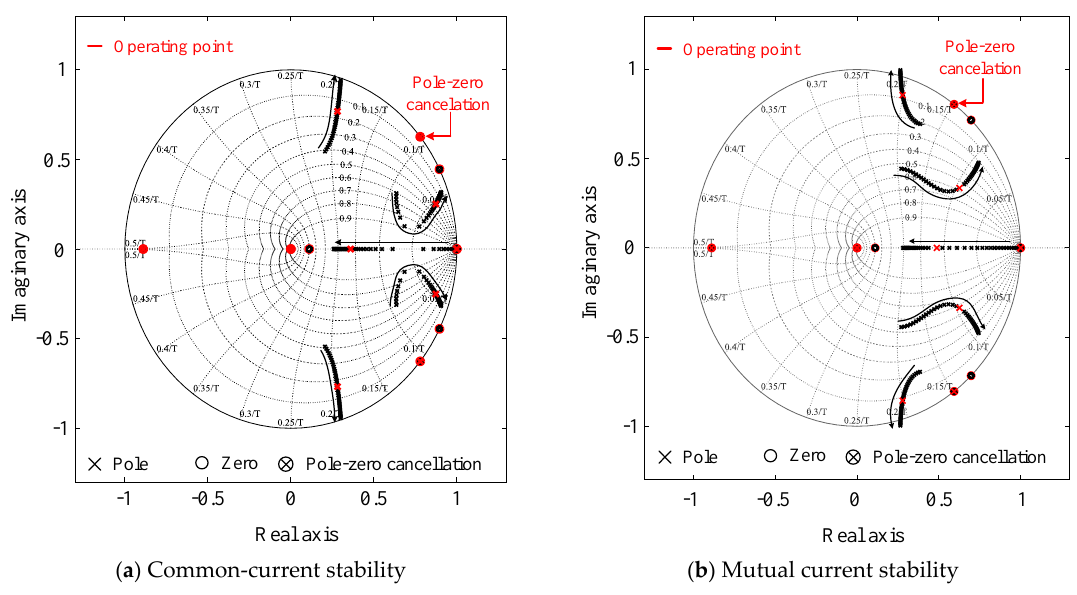
Figure 8. Pole-zero movement of G com ( z ) and G mut ( z ) under K p variation with n = 2.